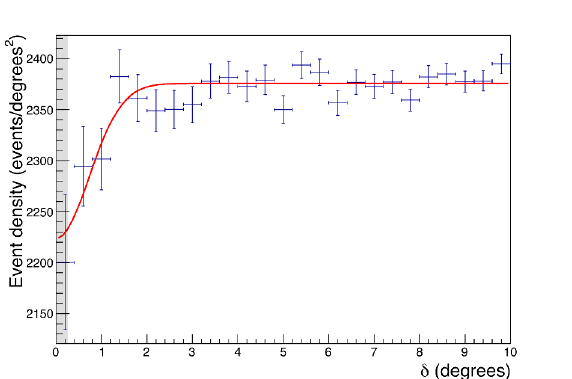
Figure 2. Measured muon event density as a function of the angular distance δ from the Moon. The smooth line is the best fit according to equation (2); the shaded area corresponds to the apparent radius of the Moon (0.26 ◦